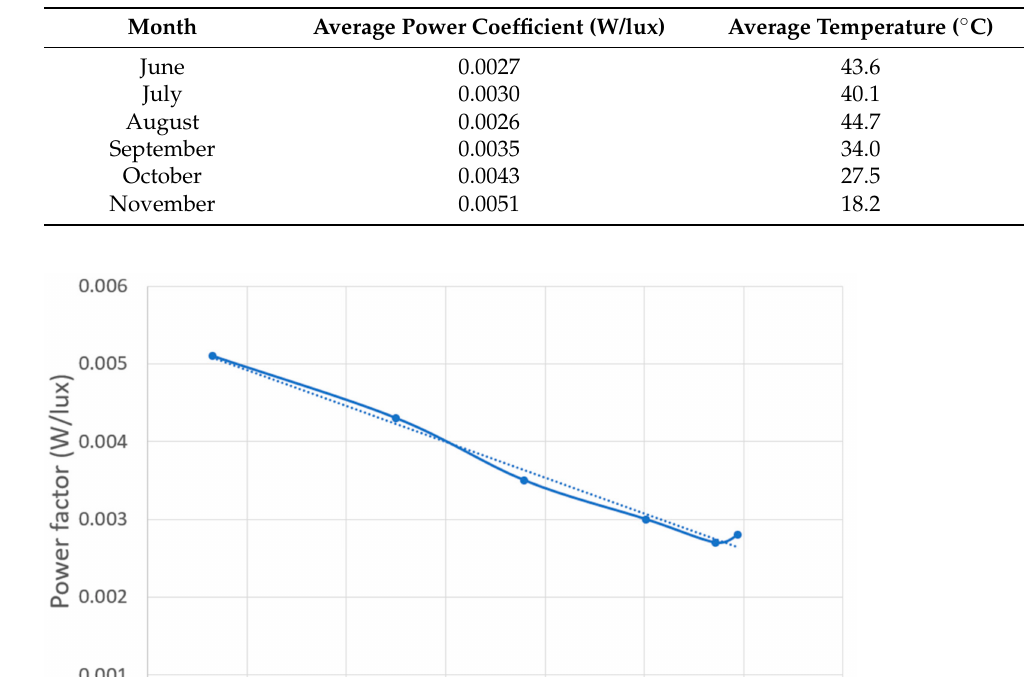
Table 1. Comparison of average power and temperature coefficients in each month.